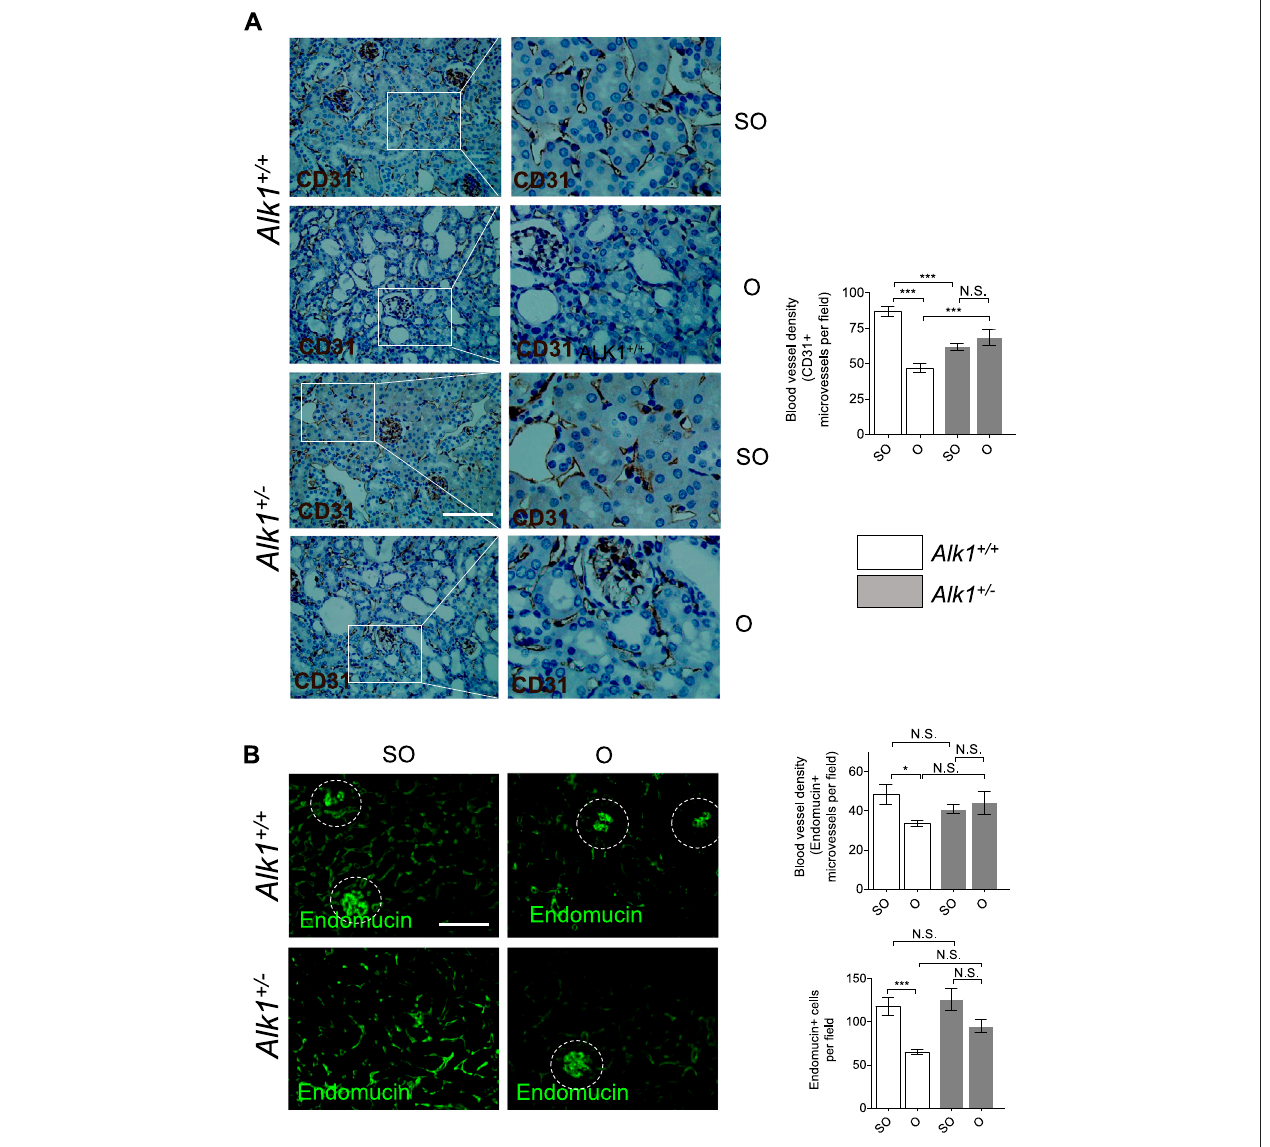
FIGURE 6 | Impaired peritubular capillaries rarefaction in Alk1 +/ − mice. (A) CD31 immunostaining in SO and O kidneys from Alk1 +/+ and Alk1 +/ − mice and blood vessel density analysis, represented as CD31 + vessels per fi eld. (B) Endomucin immuno fl uorescence staining in SO and O kidneys from Alk1 +/+ and Alk1 +/ − mice and blood vesseldensity quanti fi cation from endomucin staining,representedasmicrovesselsper fi eld(uppergraph) andendomucin+cells per fi eld (lowergraph)inSOand O kidneys from Alk1 +/+ and Alk1 +/ − mice. * p < 0.05; *** p < 0.001; N.S. Not statistically signi fi cant (Two-way ANOVA). Squares in (A) indicate the zoomed areas. Scale bar = 200 microns in both panels. Blood vessels from the glomeruli in (B) (highlighted as cropped áreas) were not counted.